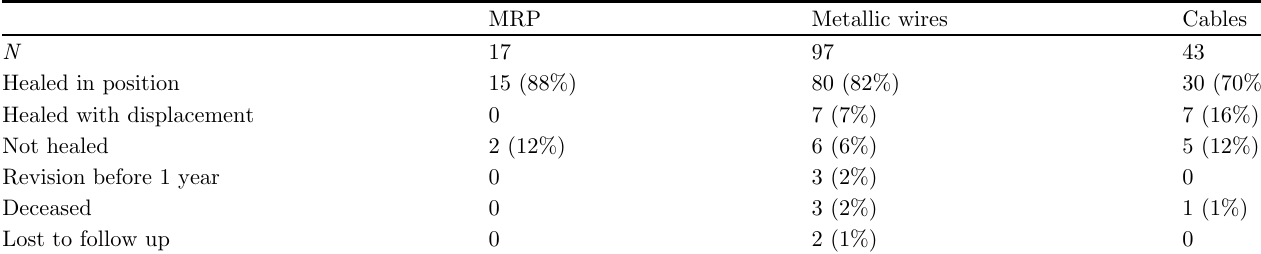
Table 2. Comparison of the different fi xation modes in ETO.